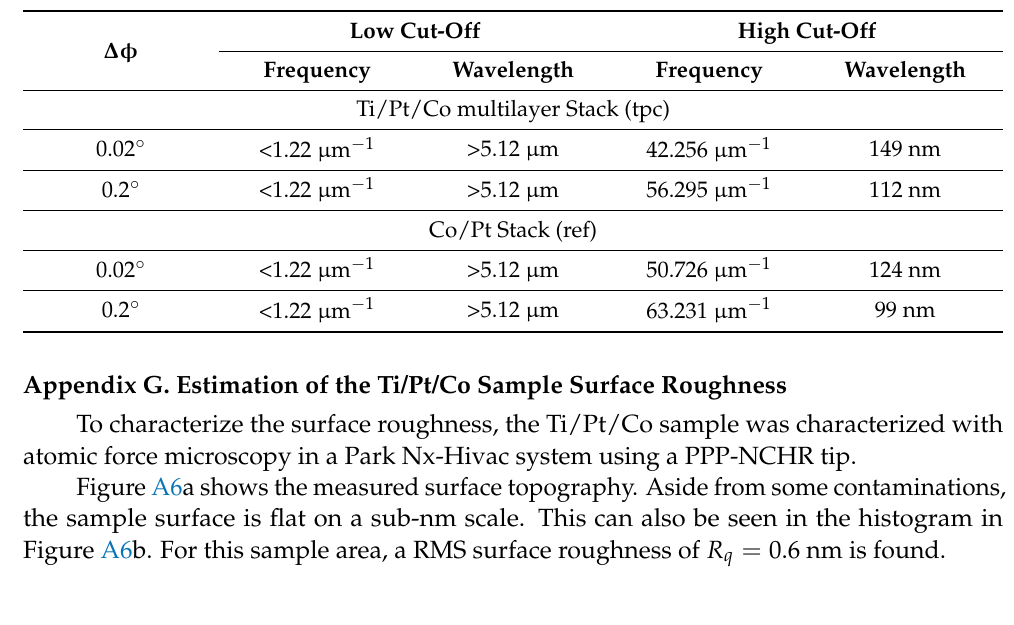
Table A2. Cut-off wave vector and corresponding wavelength data for the Ti/Pt/Co and the Co/Pt sample for two different noise levels .